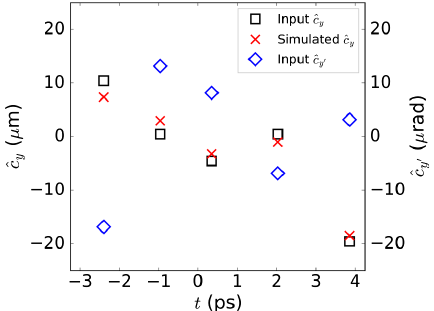
FIG. 4. Comparison between the input and simulated displace- ments in the vertical plane without any jitter. The input displace- ments are ten times smaller than those in Fig. 3. Q1 is used for scanning.